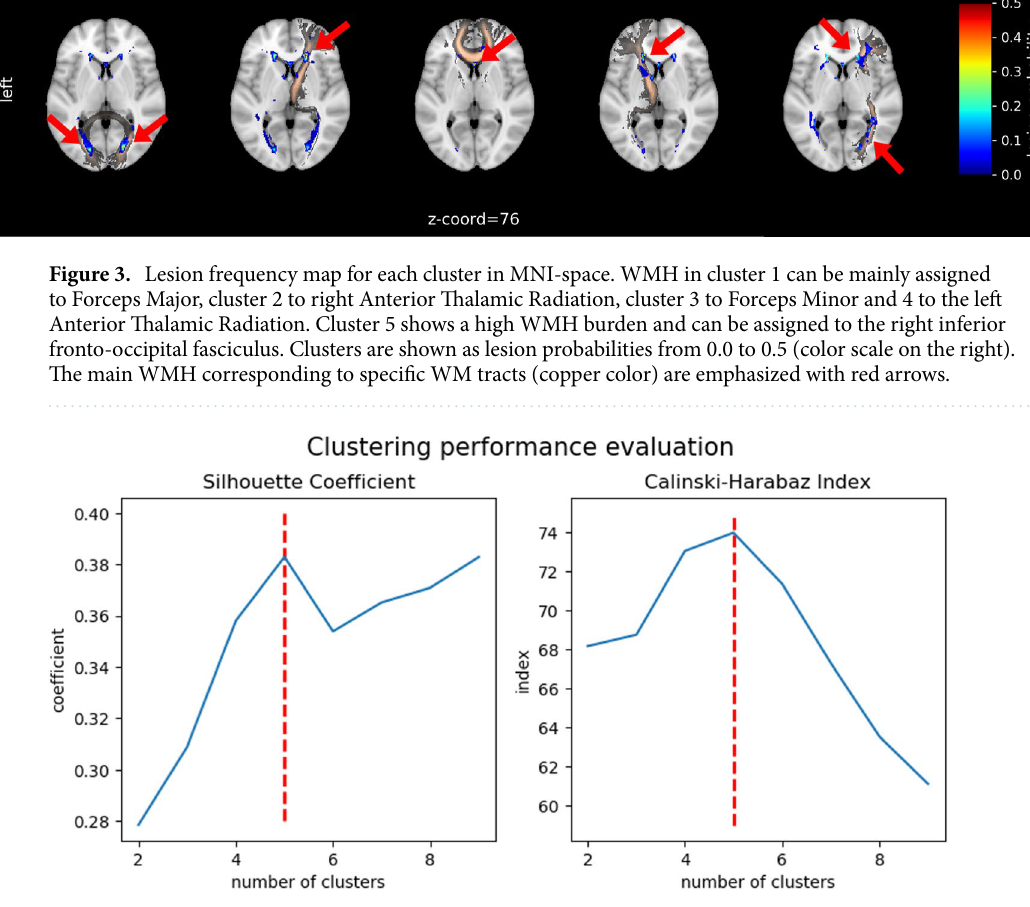
Figure 4. Clustering performance evaluation. To determine the optimal number of clusters in the hierarchical cluster analysis a consensus of two different methods were used. The mean Silhouette Coefficient (on the left) is calculated over mean intra-cluster distance divided by the minimal inter-cluster distance to the nearest cluster. Positive values indicate a dense clustering whereas negative an incorrect clustering. The Calinski–Harabaz index (on the right) is the ratio of the sum of distances squared between and within the clusters. A high index indicated a dense and well separated cluster. Both methods indicate an optimal number of clusters of